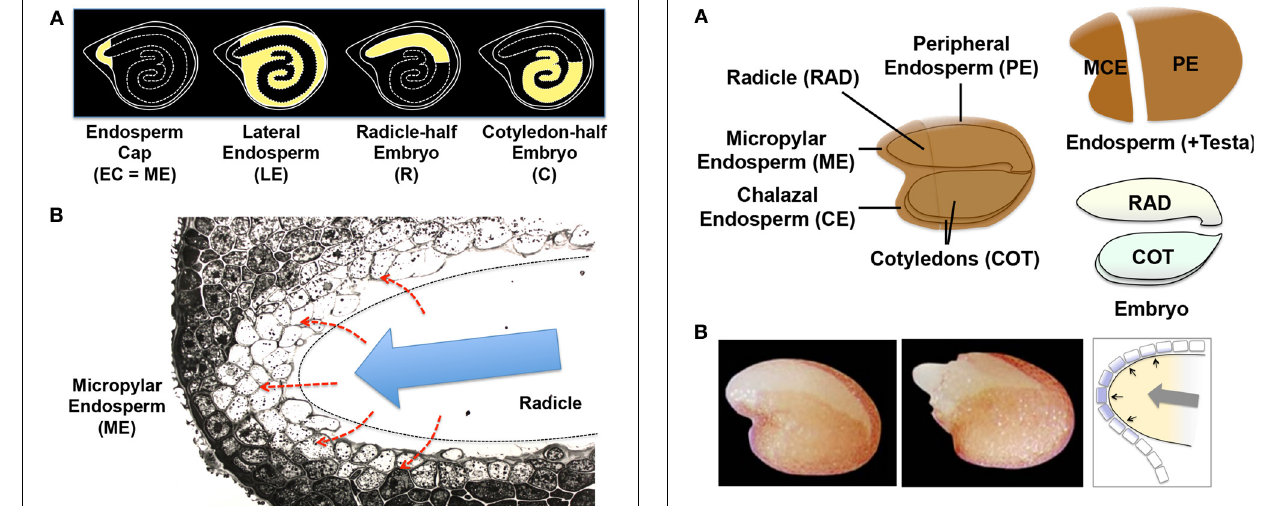
FIGURE 7 | Arabidopsis seed tissues and regulatory mechanisms of endosperm weakening. (A) Schematic representation of the four different tissue parts of Arabidopsis seeds used for the transcriptome analysis (Dekkers et al., 2013). The micropylar (ME) plus charazal (CE) endosperm (MCE), peripheral endosperm (PE, similar to LE), radicle (RAD) and cotyledons (COT) are indicated in the scheme. (B) Photographs of Arabidopsis seeds at testa rupture (TR, left) and endosperm rupture (ER, right). Schematic representation of ME is shown to the right with the growth potential of the embryo (gray arrow) and pressure (black arrows) placed onto the single cell layer of endosperm (with purple filling). known to be induced by touch or thigmotropism (Braam,